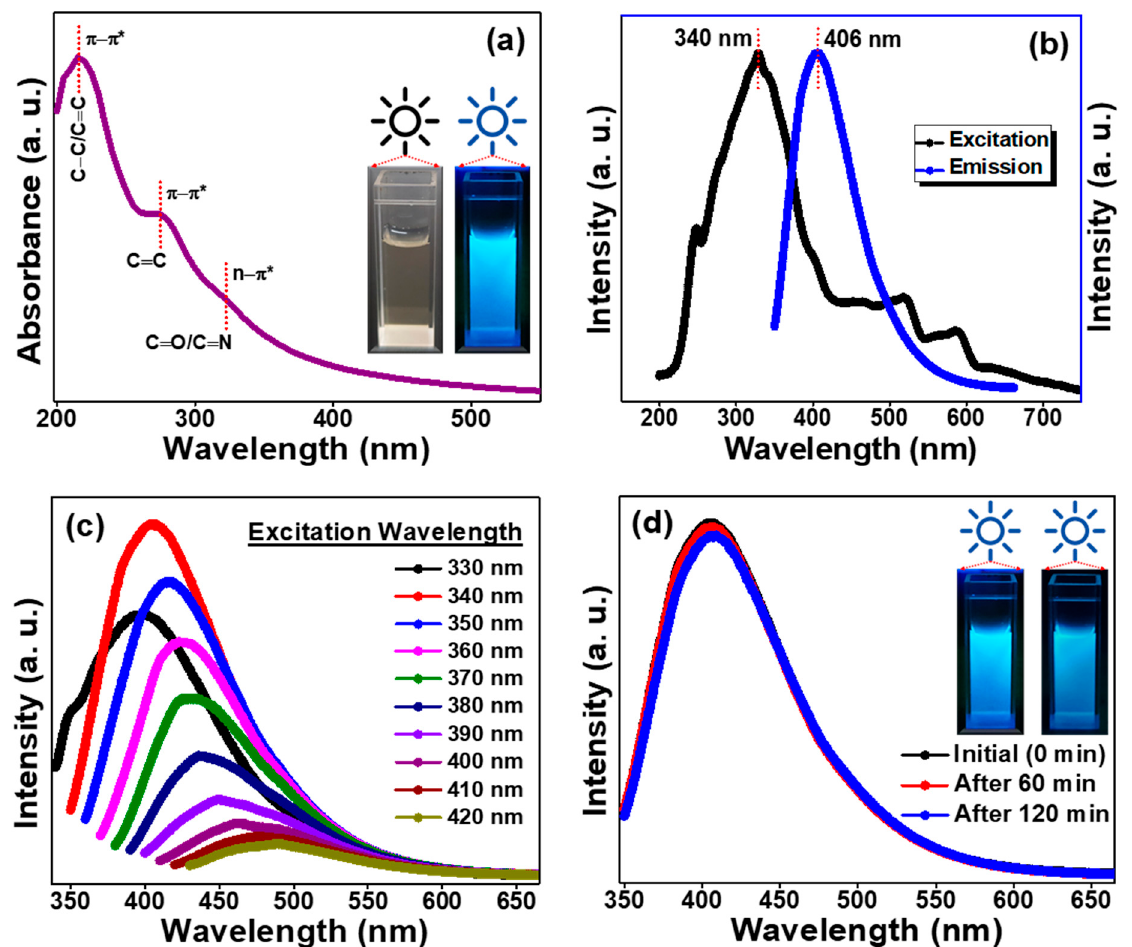
Figure 5. ( a ) UV-vis absorption spectrum (inset: photographic images of synthesized F-CNDs in aqueous solution under daylight ( left ) and 365 nm UV light ( right )); ( b ) fluorescence excitation and emission spectra, and ( c ) fluorescence excitation-dependent emission spectra of synthesized F-CNDs. ( d ) Fluorescence emission spectra of synthesized F-CNDs before and after continuous irradiation with 365 nm UV light (inset: photographic images of synthesized F-CNDs in aqueous suspension under 365 nm UV light before (0 min) and after (120 min) continuous irradiation with 365 nm UV).